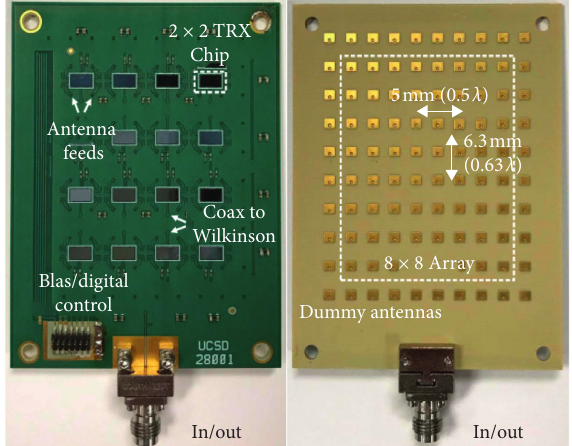
Figure 5: Top and bottom views of the 12-layer 64-element phased- array Printed Circuit Board (PCB) [51] ©2018 IEEE.